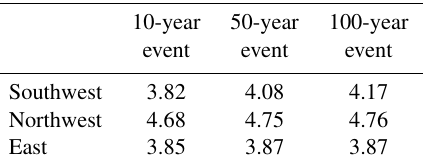
Table 6. BIC values for different GPD models fitted to the tree-ring- reconstructed PDSI values from 1903 with climate variables for all clusters. Predictors in Constant AO Snow T min Precip the scale parameters Northwest 30.21 31.37 32.16 32.20 31.96 Southwest 50.38 50.82 53.00 52.09 52.76 East 65.49 68.84 68.62 68.86 67.80